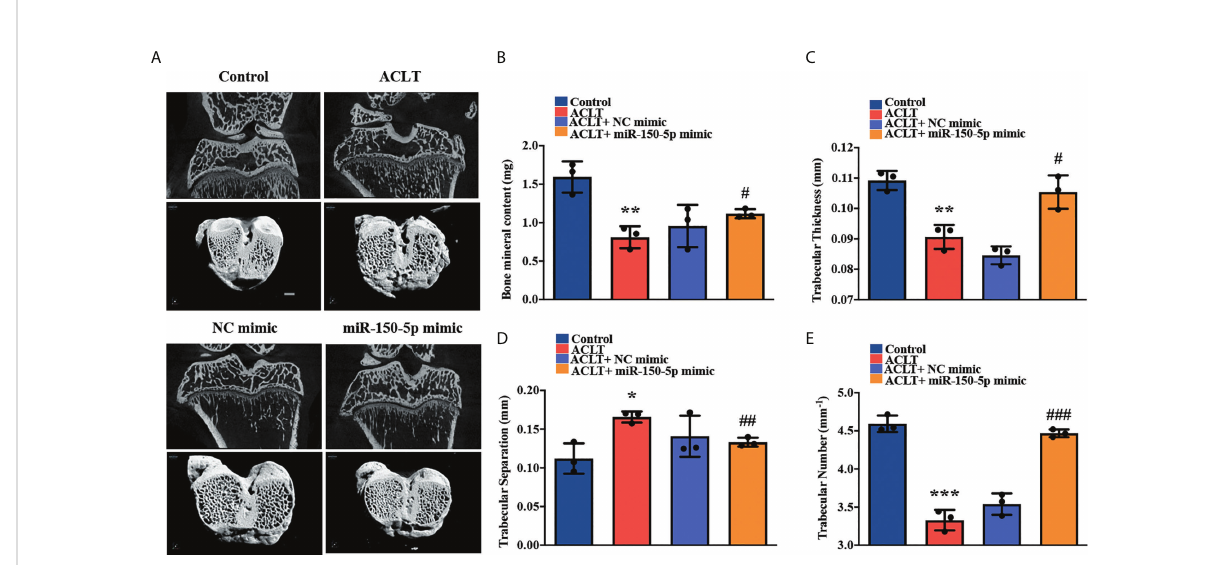
FIGURE 6 miR-150-5p alleviates the severity of OA in rats. (A) Micro ‐ CT images from subchondral bone in rat knees from each group (Control, ACLT, ACLT + NC mimic, and ACLT + miR-150-5p mimic) were scanned using SkyScan micro-CT scanners. Micro-CT parameters analyzed (B) the percentage of subchondral bone volume in tissue volume, (C) trabecular thickness, (D) trabecular separation, and (E) trabecular numbers in all rats, in three independent experiments. * p < 0.05, ** p < 0.01, *** p < 0.001 compared with Control; # p < 0.05, ## p < 0.01, ### p < 0.001 compared with ACLT